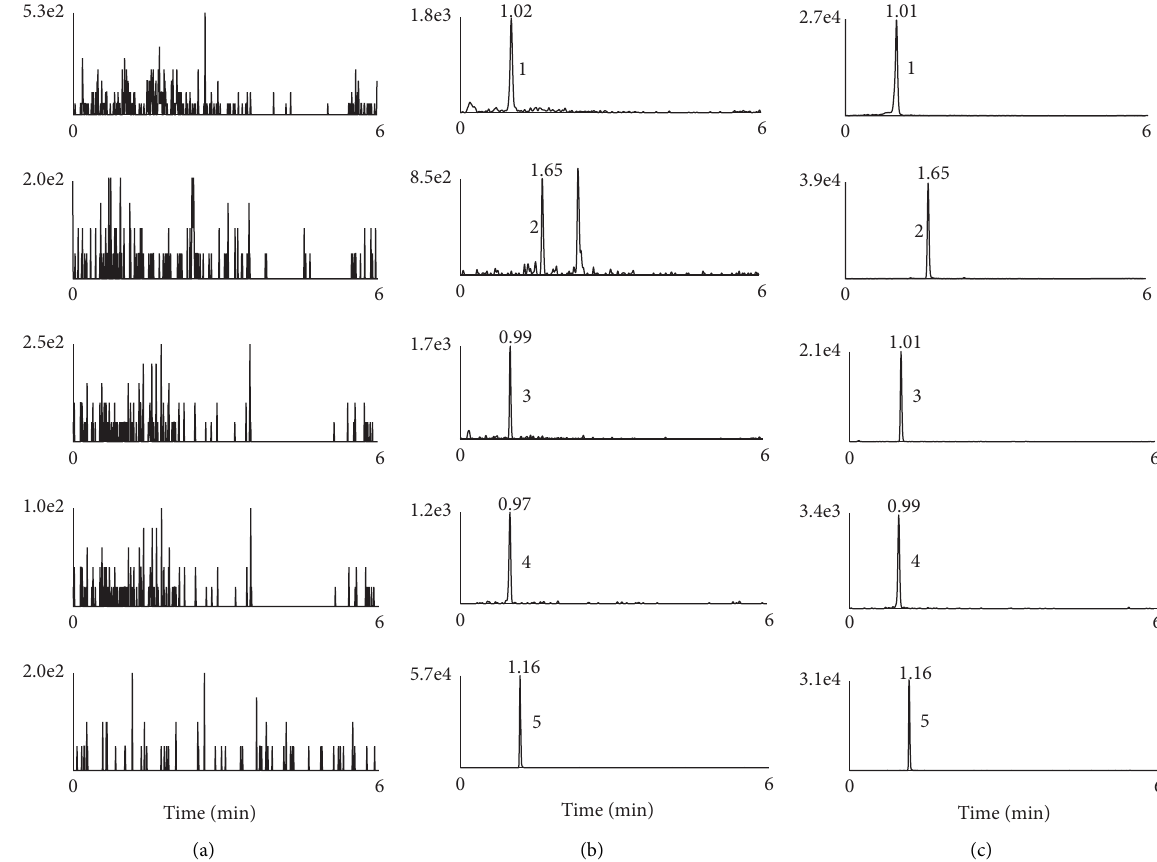
Figure 2: Typical chromatograms of four analyte and IS in rat plasma: (a) blank plasma samples, (b) blank plasma samples spiked with four analytes (LLOQ) and IS, (c) rat plasma samples at 0.5h after oral administration the Nauclea ofcinalis extracts spiked with IS; (1) chlorogenic acid, (2) naucleactonin C, (3) khaephuoside A, (4) 3,4-dimethoxyphenyl-1-O- β -apiofuroseyl(1 ⟶ 2)- β -D-glucopyranoside, (5) chloramphenicol